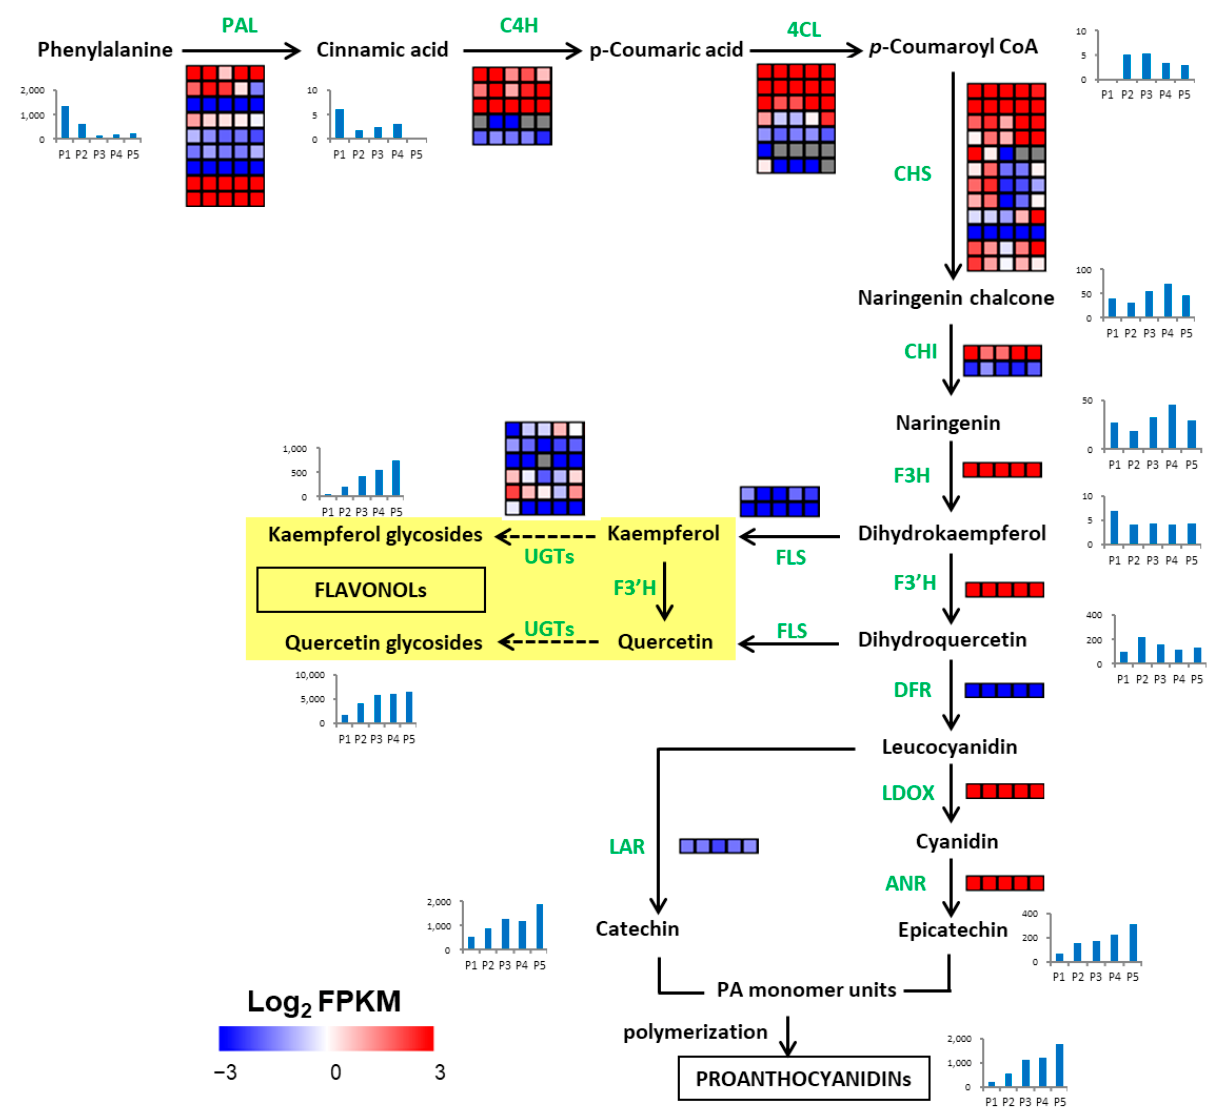
Figure 6. Transcriptional model of polyphenol biosynthesis in the developing walnut endopleura. The descriptions of genes is listed in Table 3. The rows represent different genes encoding the same enzyme, and the five squares in each horizontal row correspond to five stages (P1, P2, P3, P4, and P5). Grey squares mean FPKM = 0. The blue bar graph indicates the change in the content of metabolites in the metabolome (Table 2), and the Y -axis of the bar graph shows the relative content. Some transcription factors, such as MYB111, TTG1, TT8, TT2, MYB5, EGL3, TT1, TT16, and TTG2, play key roles in plant polyphenol synthesis (Figure 7). As shown in Table 4, seven polyphenol-related transcription factors belonged to DEGs. TT2 (Jr03G11832, Jr03G11834) and TT16 (Jr05G10903) belonged to the turquoise module, MYB5 (Jr14G11044) and TT1 (Jr08G11835) belonged to blue module, MYB111 (Jr02G12175) belonged to the brown module, and MYB111 (Jr08G10063) belonged to the green module. MYB5 (Jr14G11044) and TT1 (Jr08G11835) had similar expression patterns with PAL , C4H , 4CL , CHS , CHI , F3H , LDOX, and ANR , and the expression pattern of MYB111 was positively correlated with the accumulation pattern of quercetin, kaempferol, and proanthocyanidins. Therefore, MYB111 (Jr02G12175), MYB5 (Jr14G11044), and TT1 (Jr08G11835) may play an important role in the polyphenol synthesis in walnut